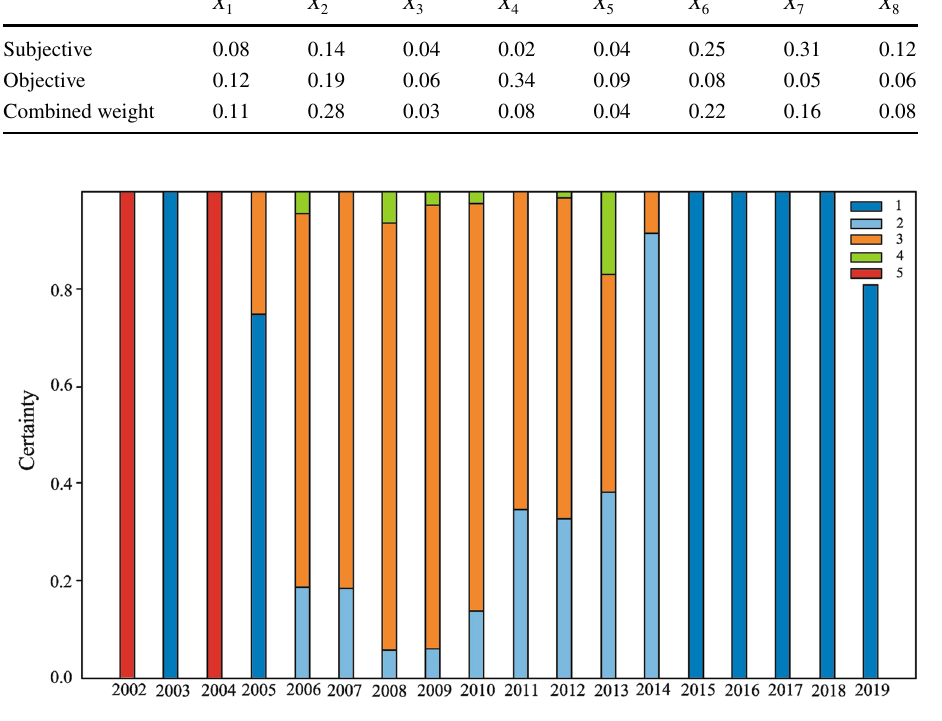
Table3 The evaluation index weight of water resources carrying capacity in Henan Province